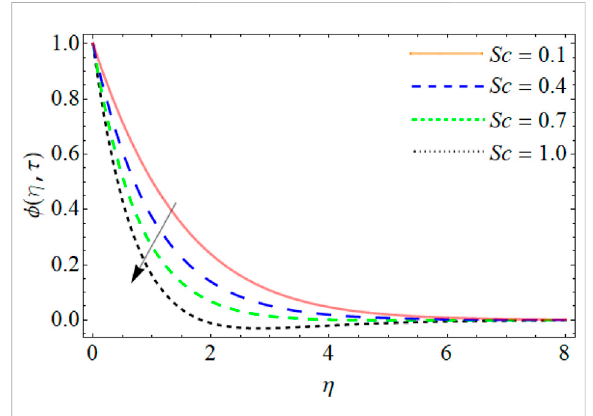
FIGURE 15 Mass outlines ϕ ( η , τ ) versus Schmidt number Sc .